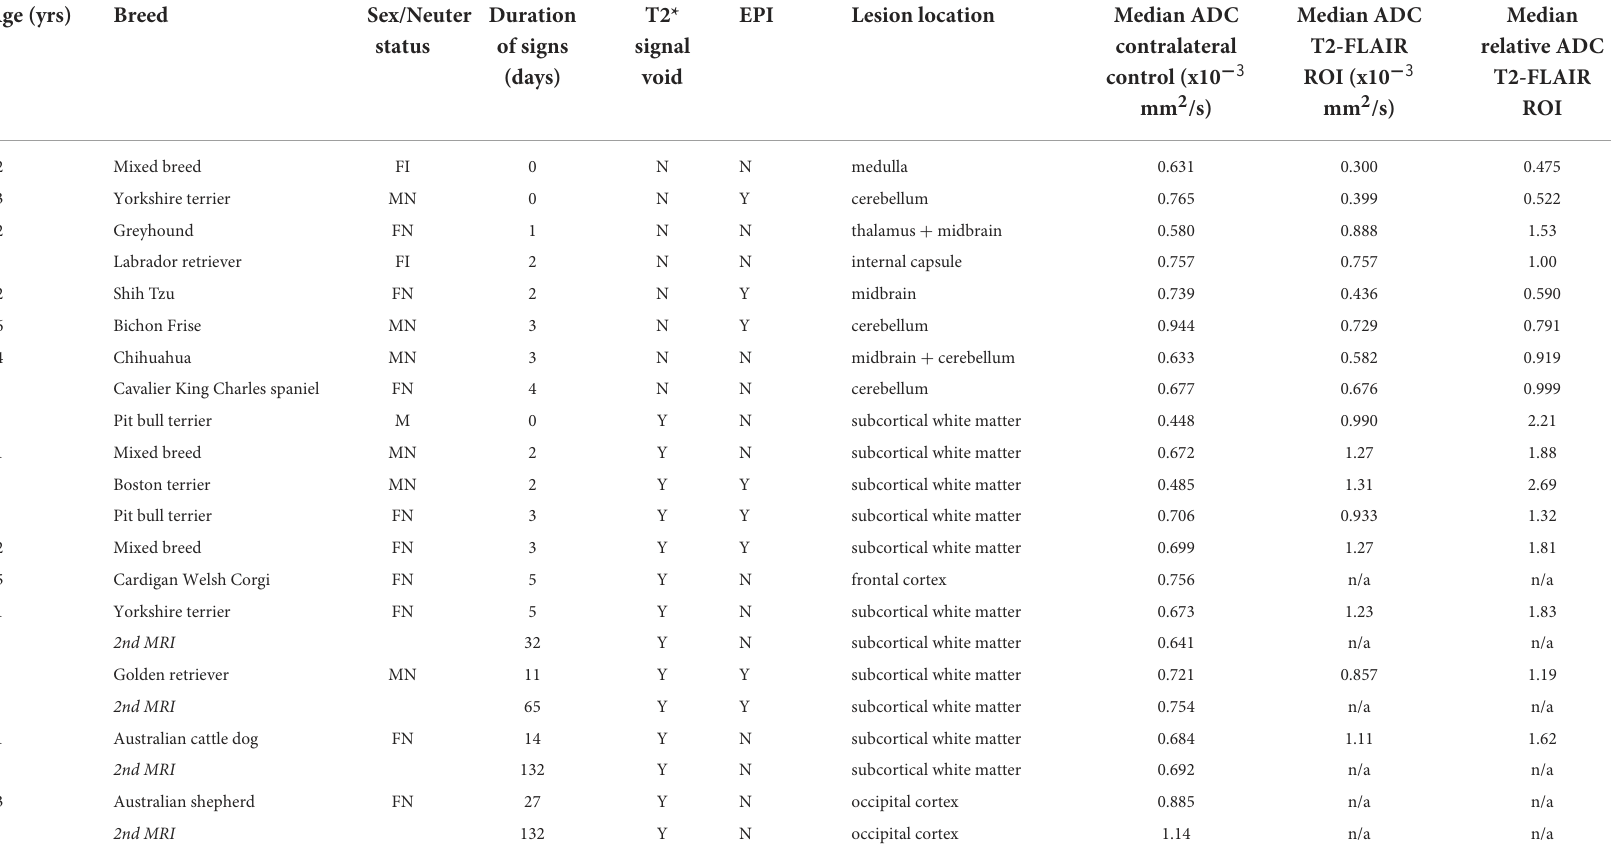
TABLE 1 Clinical data for 22 image sets included in this